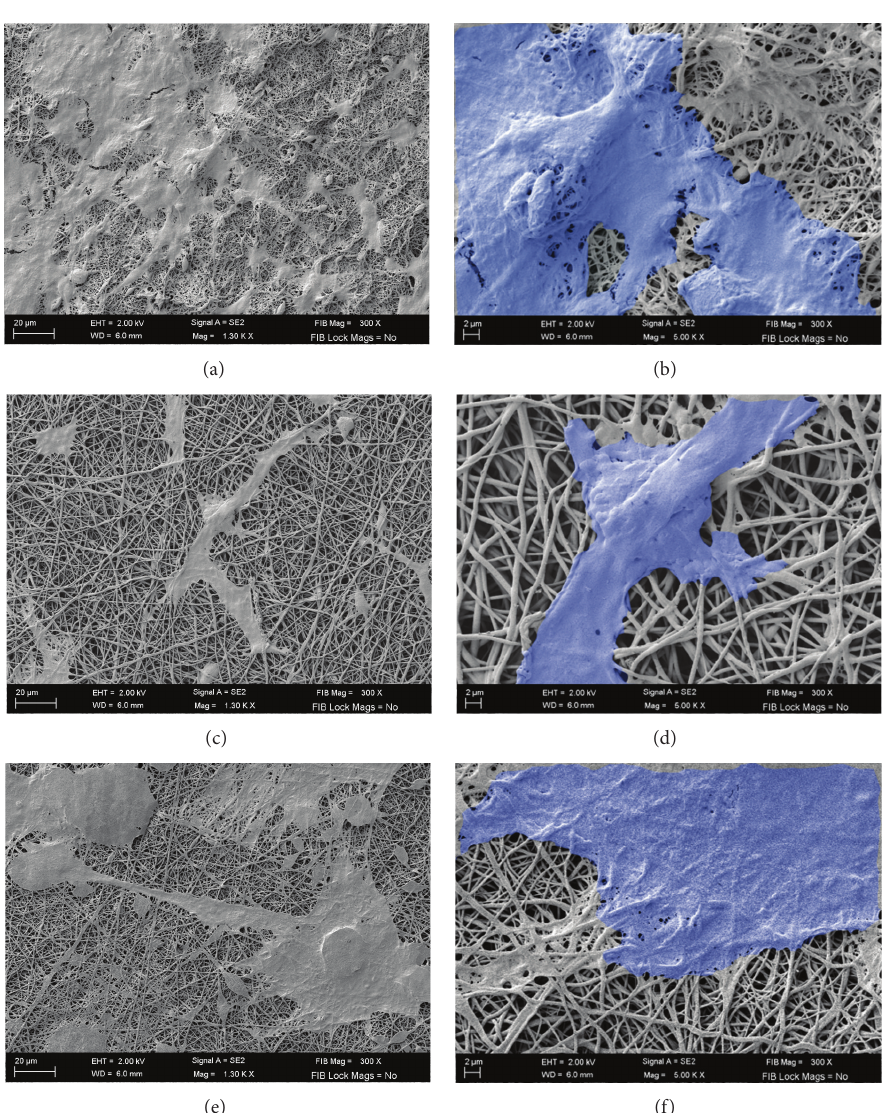
Figure 4: The micrograph presenting glial cells which adhere to material 5/5 PU/PLDL (a, b), 6/4 PU/PLDL (c, d), and 8/2 PU/PLDL (e, f); magnifications 1300x (a, c, e) and 5000x (b, d, f). Pseudocoloured images distinguish cells from biomaterials on pictures (b), (d), and (f) (blue). Scanning electron microscope, magnifications 1300x (a, c, e) and 5000x (b, d, f), scale bars presented on